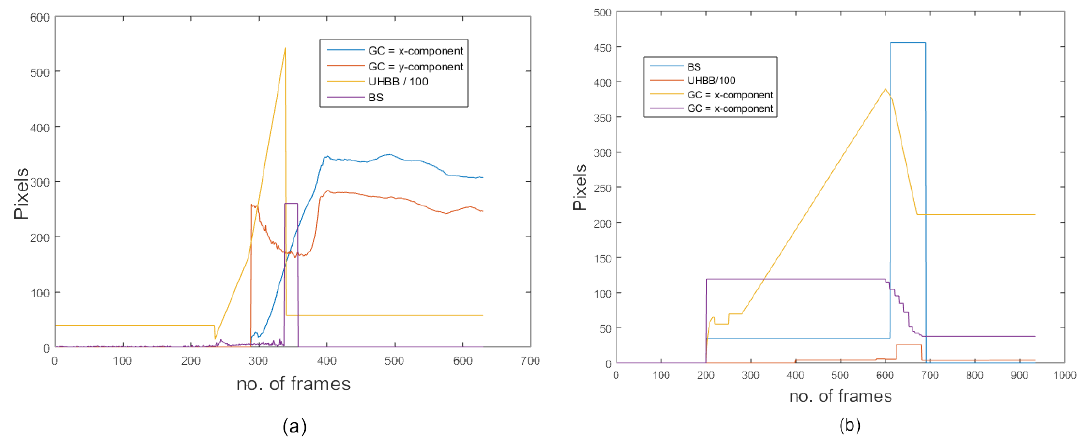
Figure 2. The temporal variation in body speed (B.S.), upper half area of the bounding box (U.H.B.B), and x -component and y -component of the geometric centre (G.C.) of a falling person on the MCF dataset: ( a ) camera 2, video 2; ( b ) camera 3, video